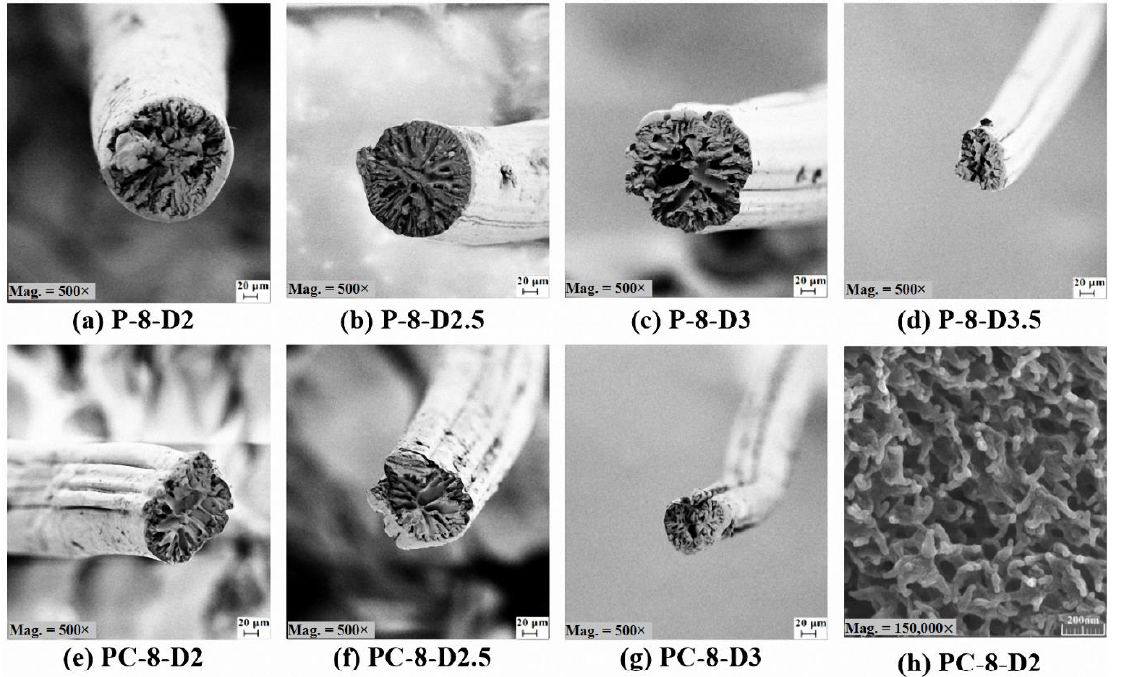
Figure 4. ( a – g ) FESEM images of PAN and PAN/CNT fibers spun at different jet stretch ratios at magnification of 500× ( h ) Internal morphology of PC-8-D2 fibers at magnification of 150,000×.